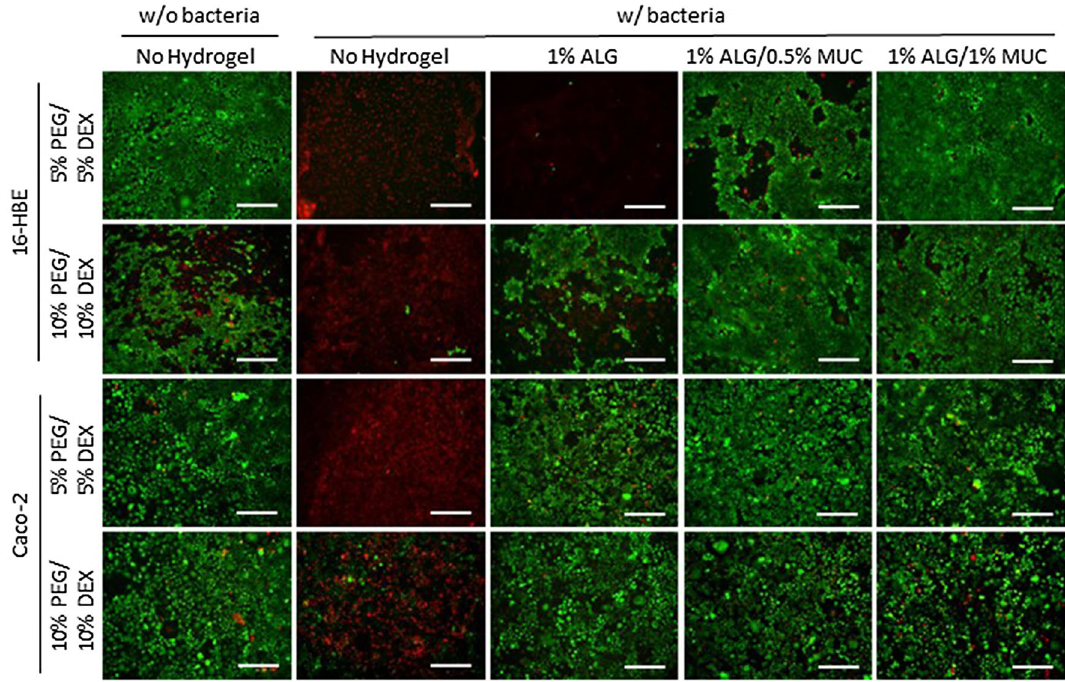
Figure 3. Live/Dead staining images of 16-HBE and Caco-2 monolayers after a 12-h co-culture with P. aeruginosa and S. flexneri , respectively, deposited with a PEG-DEX ATPS either with or without alginate-based hydrogels between mammalian cells and ATPS. Bacteria were deposited using a 5% PEG/5% DEX ATPS or 10% PEG/10% DEX ATPS over mammalian cells with an alginate-based hydrogel (1% ALG, 1% ALG/0.5% MUC, and 1% ALG/1% MUC) overlay, where a DEX droplet with or without bacteria was deposited directly onto mammalian cells as controls (scale bar = 500